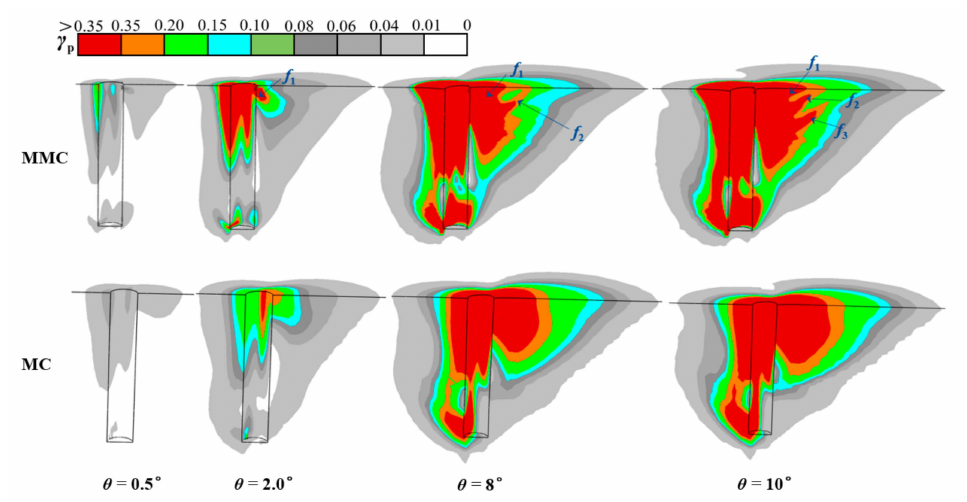
Figure 7. Comparison of the development process of the plastic zone around the pile (scaling factor: 0.1).